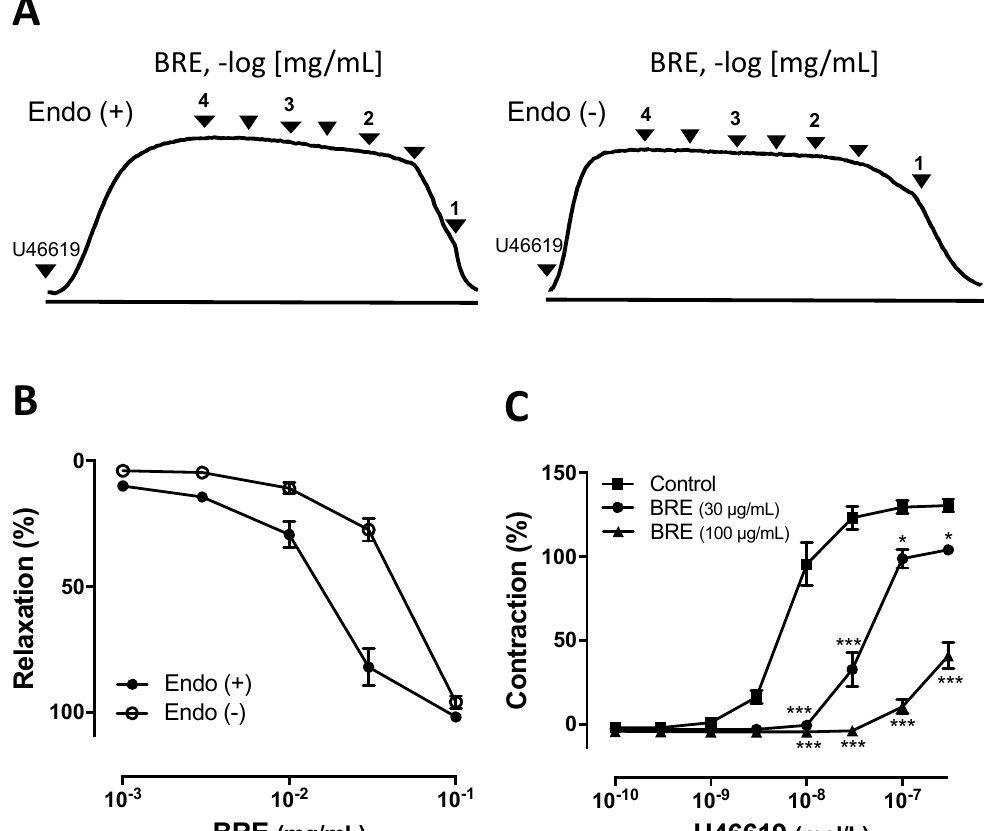
Figure 1. Boesenbergia rotunda rhizome methanol extract (BRE) induced concentration-dependent relaxation and prevented contraction in porcine coronary artery rings. Intact and endothelium-denuded rings were contracted with U46619 before the construction of BRE concentration-relaxation. ( A ) representative tracing; ( B ) accumulated figure; ( C ) coronary artery rings were treated with BRE at the indicated concentration before the construction of a concentration–contraction curve in response to U46619. Results are shown as mean ± SEM of 5–10 experiments. * p < 0.05, *** p < 0.001 versus control.